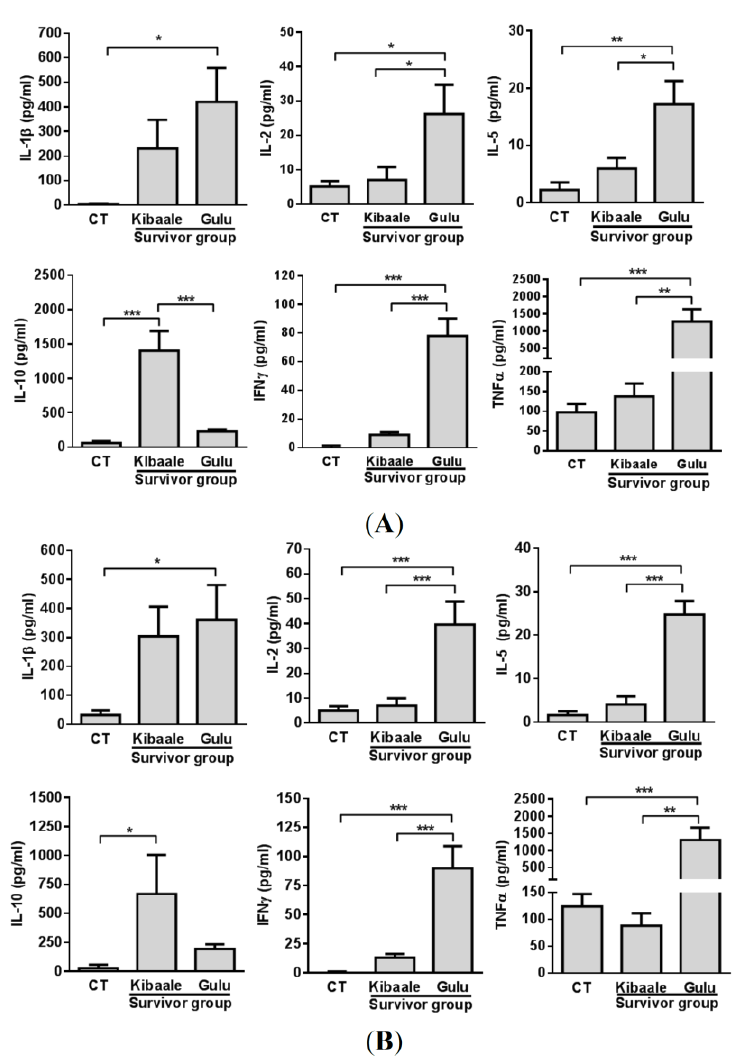
Figure 2. Cytokine levels following SUDV/Gul whole antigen ( A ) and GP 1–649 ( B ) stimulation of whole blood from Kibaale (1-year) and Gulu (12-year) ebolavirus